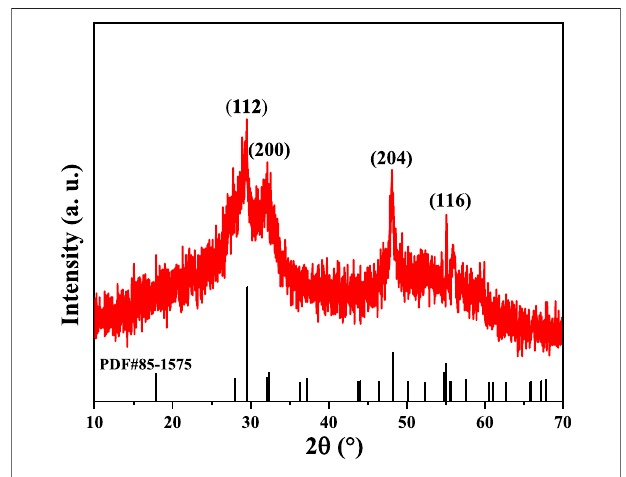
FIGURE 1 | XRD pattern of our synthesized CuInS 2 .